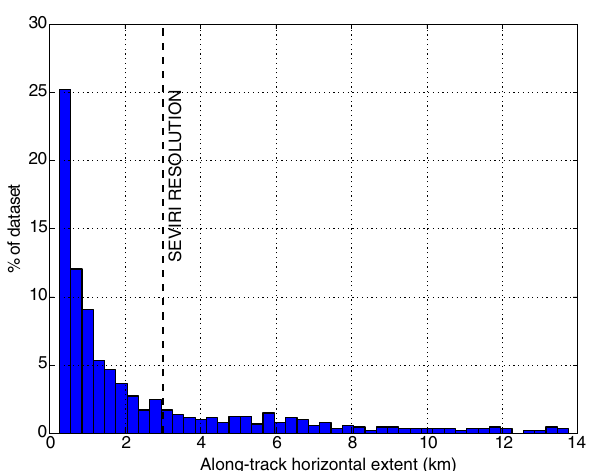
Figure 2. Distribution of cloud sizes from the full aircraft dataset; 67% of the clouds detected by the aircraft exhibit a horizontal ex- tent smaller in size than SEVIRI’s